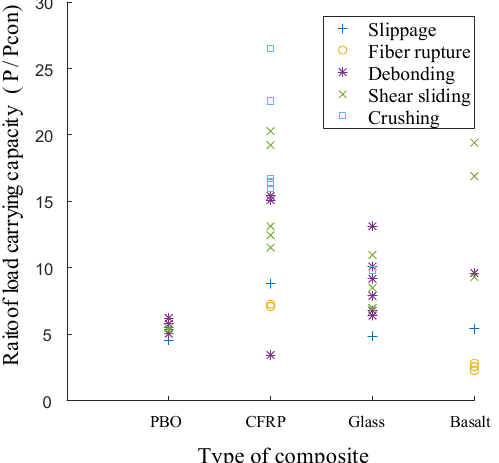
Figure 33. An increase in the load-carrying capacity ratio vs. composite type with respect to